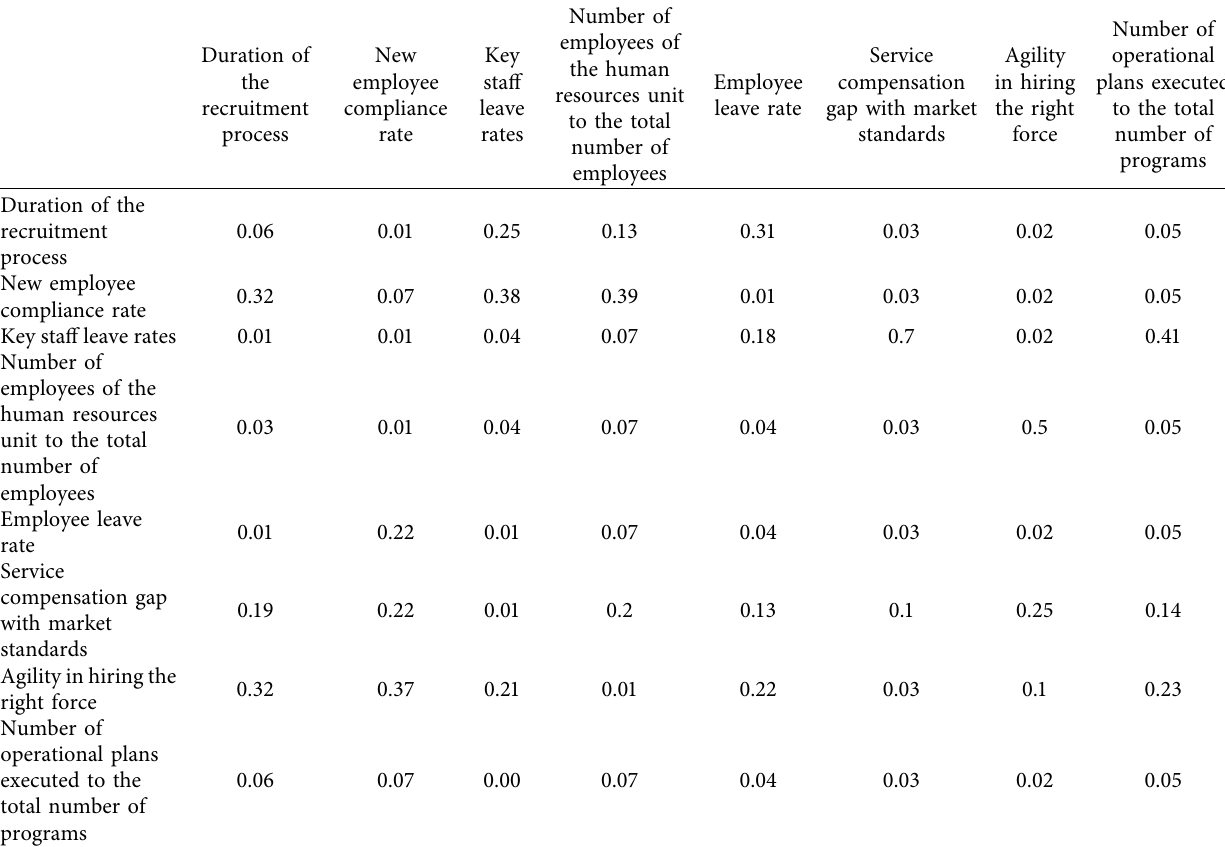
Table 9: Normalization table of hierarchical analysis process in terms of internal processes.